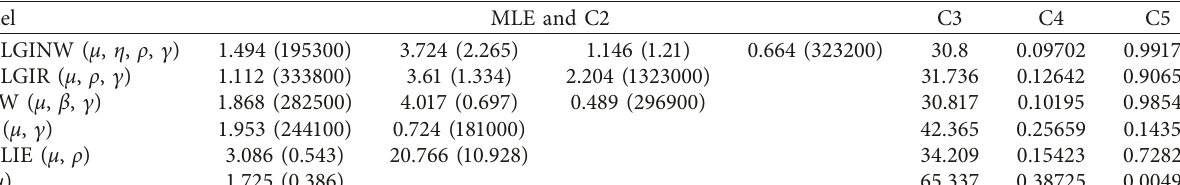
Table 3: MLEs, C2, C3, C4, and C5 for the dataset.